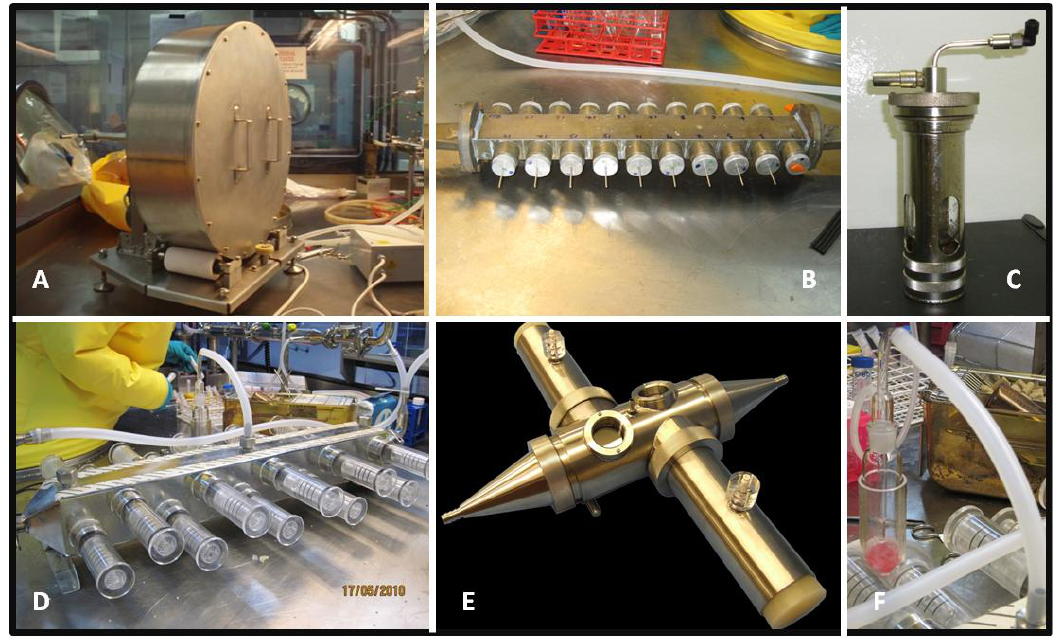
Figure 3. Aerosol apparatus. ( A ) 40 L Goldberg drum used for aerosol survival studies inside the isolator; ( B ) A sow used for exposing microthreads to aerosols for aerosol stability studies, in use inside an isolator; ( C ) A Collison nebuliser used to generate small particle aerosols; ( D ) Mouse exposure apparatus in use inside an isolator; ( E ) The marmoset exposure apparatus; ( F ) An AGI sampling during a mouse exposure inside an